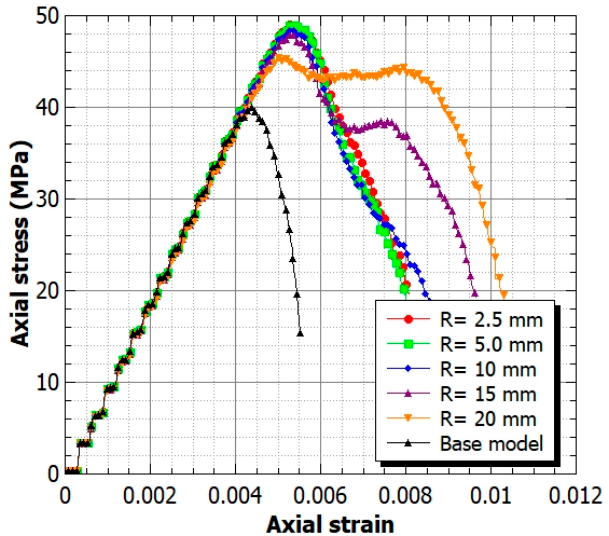
Figure 8. Axial stress, axial strain curves of tested specimens in Group 2.